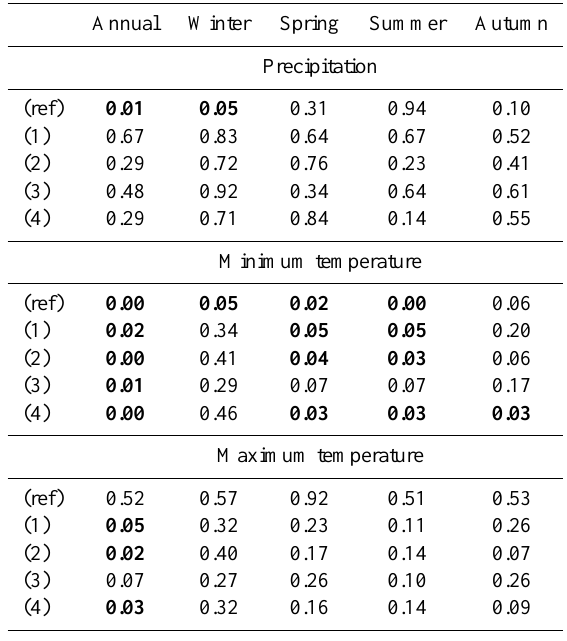
Table 2. Annual and seasonal Mann Kendall p-value over the period 1953–2000.